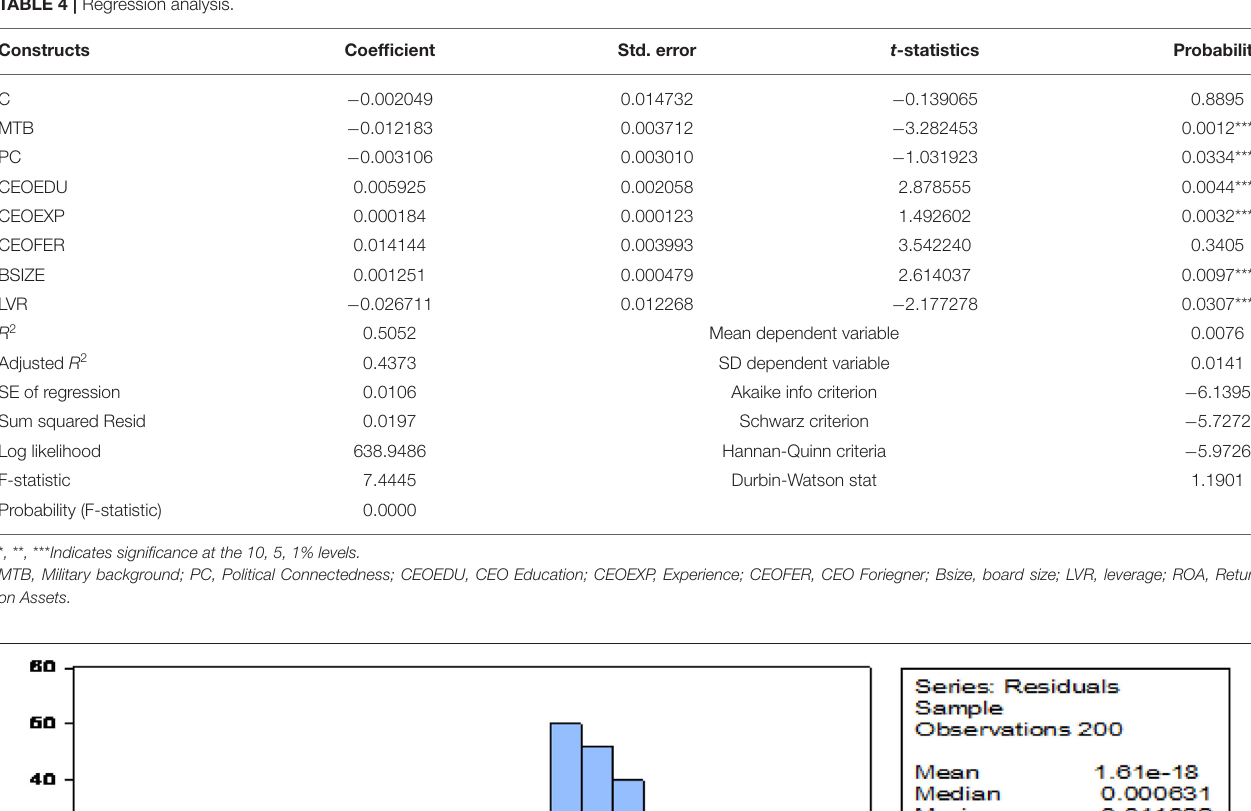
TABLE 4 | Regression analysis.